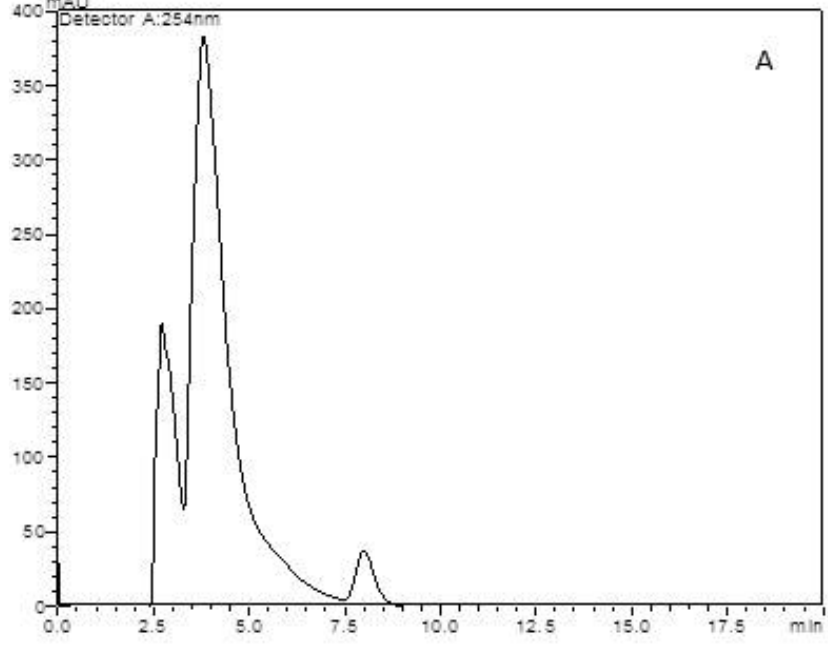
Figure 3. HPLC chromatograms. ( A ) Pomegranate extract solution chromatogram; ( B ) Extract-loaded microparticle chromatogram; ( C ) Extract-loaded chitosan microparticles. Run time 20 min, flow rate 1.0 mL/min and wavelength 254